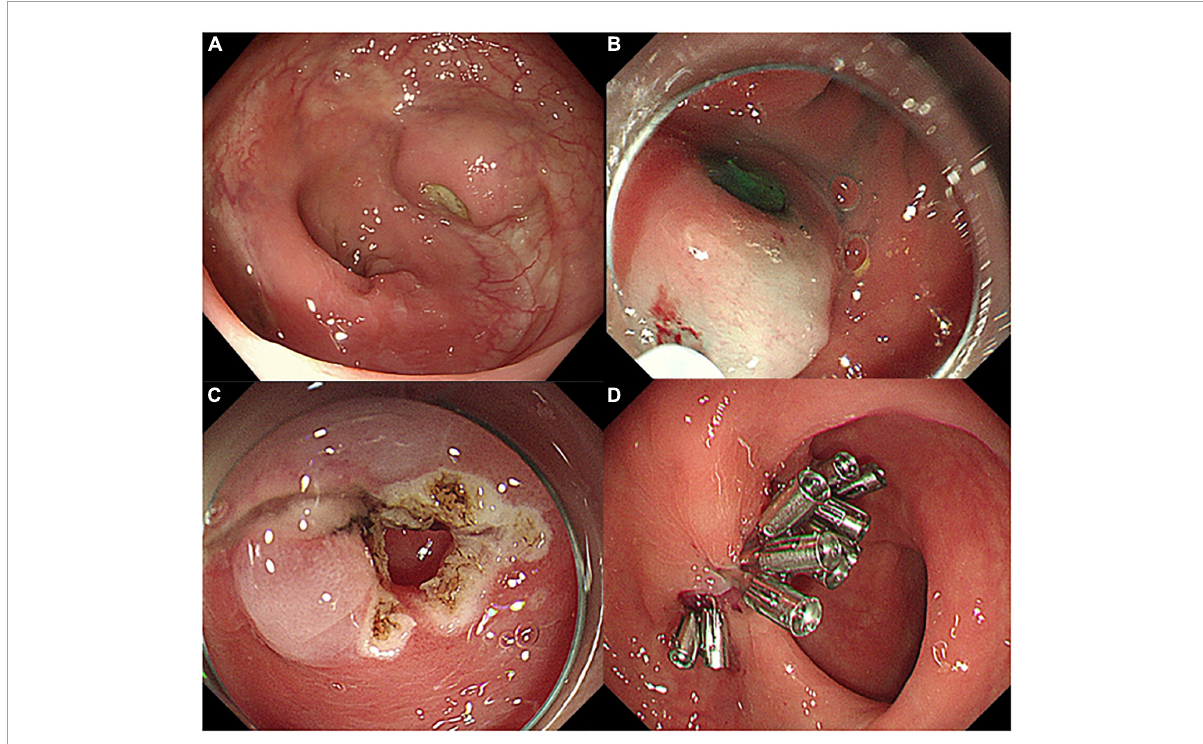
FIGURE1 Endoscopic images of diverticulum and procedures of endoscopic therapy. (A) Anastomotic diverticulum combined with stercorolith incarceration, (B,C) endoscopic mucosal incision and lithotomy, and (D) diverticulum closed with titanium